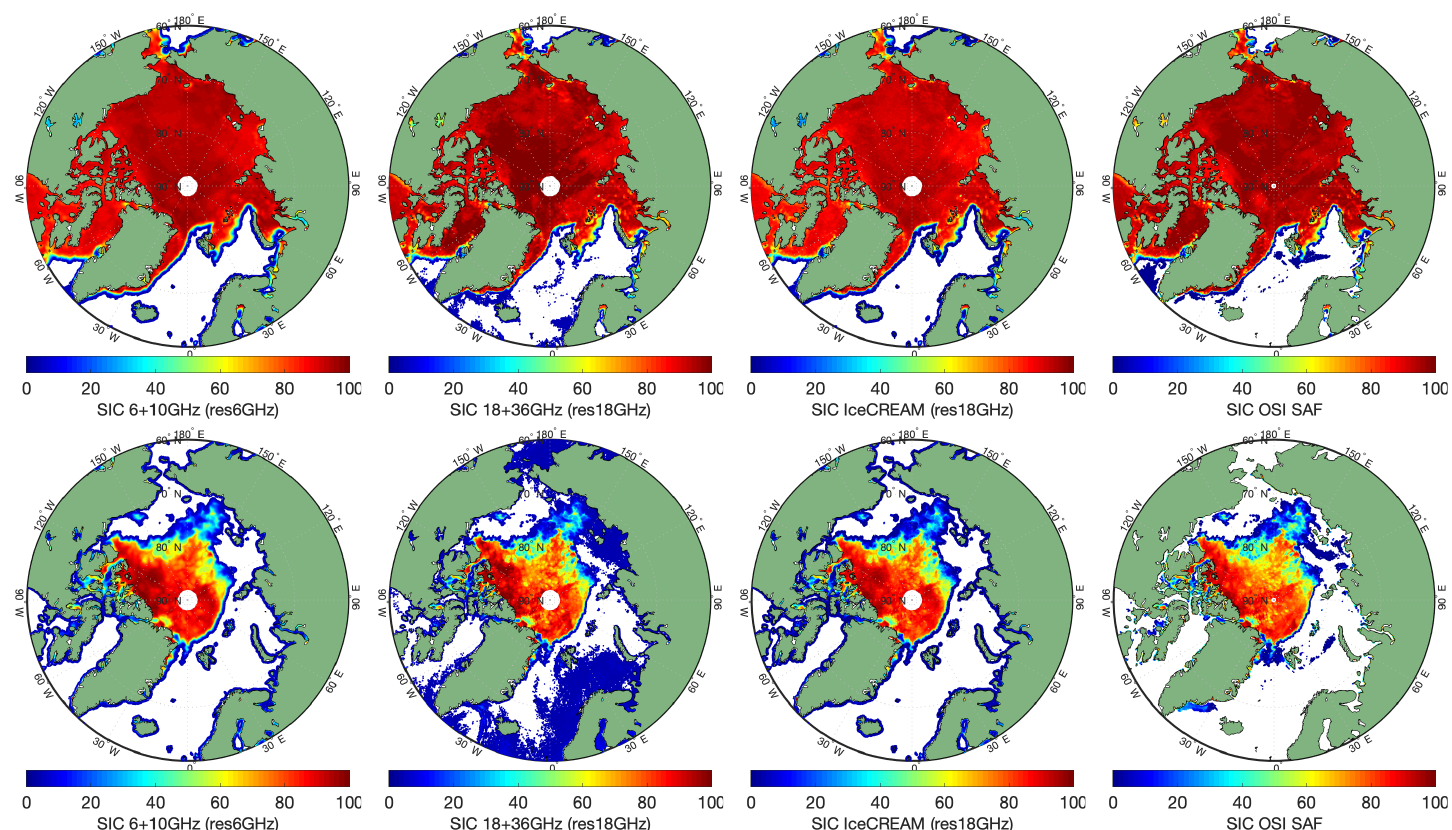
Figure 9. Over the north polar region, from left to right, comparison of our 6+10GHz and 18+36GHz algorithms, the all channel IceCREAM results, and the original OSI SAF estimates (using 18 and 36 GHz V polarization). Top: 30 January, 2028. Bottom: 30 August, 2018. Note that the values of SIC below 5% have been suppressed for all the